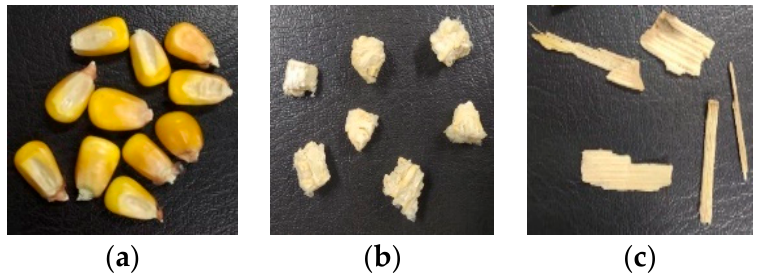
Figure 1. Cleaning loss material. ( a ) Corn kernel; ( b ) crushed corncob; ( c ) crushed bracteal leaf.